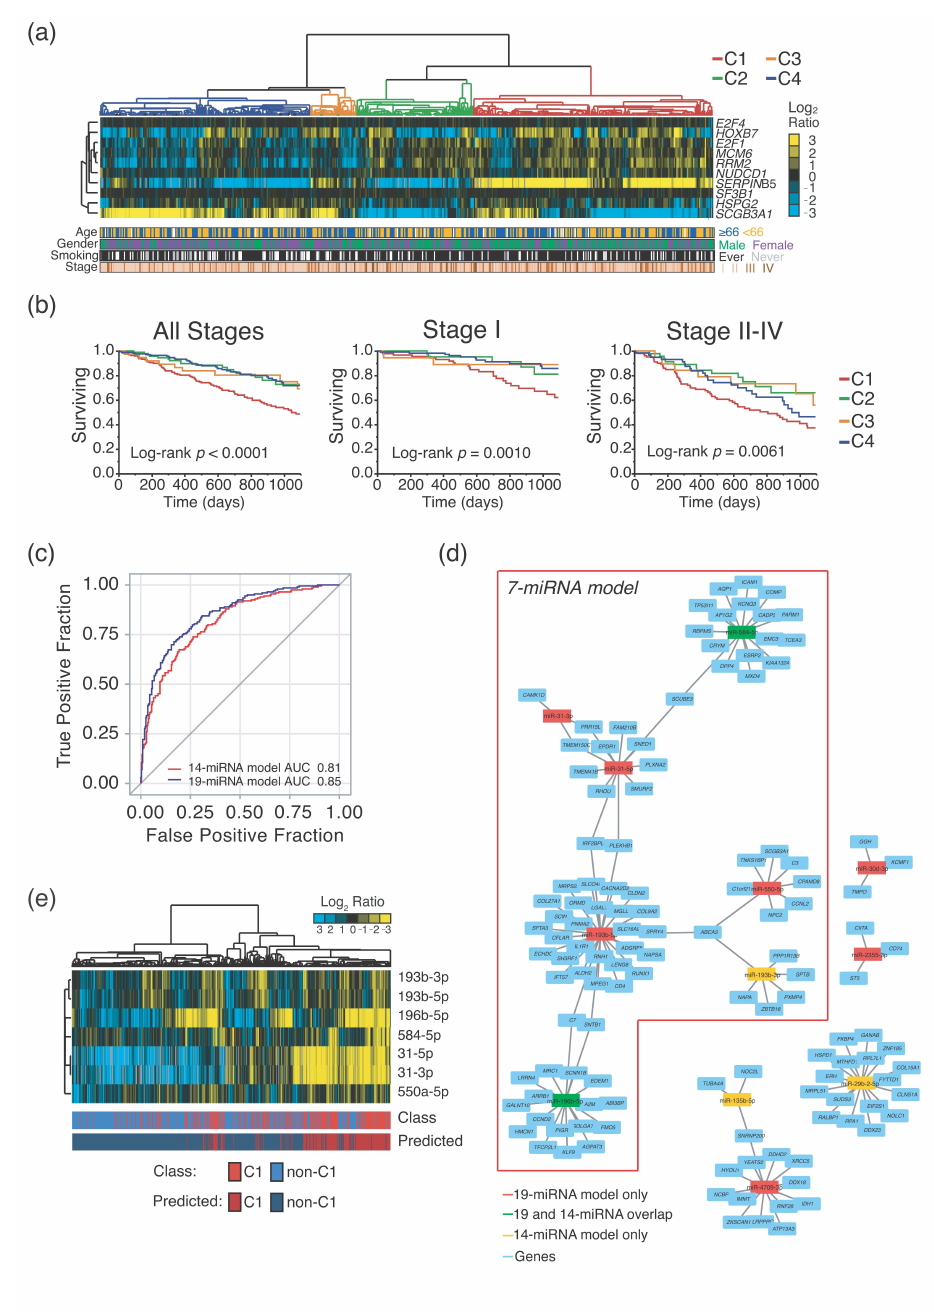
Figure 2. mRNA and miRNA expression profile analysis of the TCGA-LUAD cohort. ( a ) Hierarchical clustering analysis of the 10-gene expression signature. C1-C4 clusters are colored as per the legend. Age, gender, smoking status and stage are colored as per the legend; Unavailable information is colored in white. ( b ) Kaplan–Meier curves for 3-years overall survival stratified by C1–C4 clusters. Log-rank p -values are shown for C1 vs. non-C1 clusters (C2-C4) comparison. ( c ) Receiver operating characteristic (ROC) curves showing the False Positive Fraction and True Positive Fraction of the 19- (in blue) and14-miRNA(inred)models. Theareasundercurve(AUC)arereported. ( d )NetworksofmiRNAderived from19-,14-and7-miRNAsmodelandcorrespondingtargetgenes. Lightbluerectanglesrepresentgenes;red rectangles represent miRNA from 19-miRNA model; yellow rectangles represent miRNA from 14-miRNA model; green rectangles represent miRNA from both 14- and 19-miRNA model. ( e ) Hierarchical clustering of 7-miRNAs in the TCGA-LUAD cohort. C1 and non-C1 tumors (defined according to the 10-gene signature) are colored as per the legend. Predicted C1 and non-C1 tumors (defined according the 7-miRNA logistic model) are colored as per the